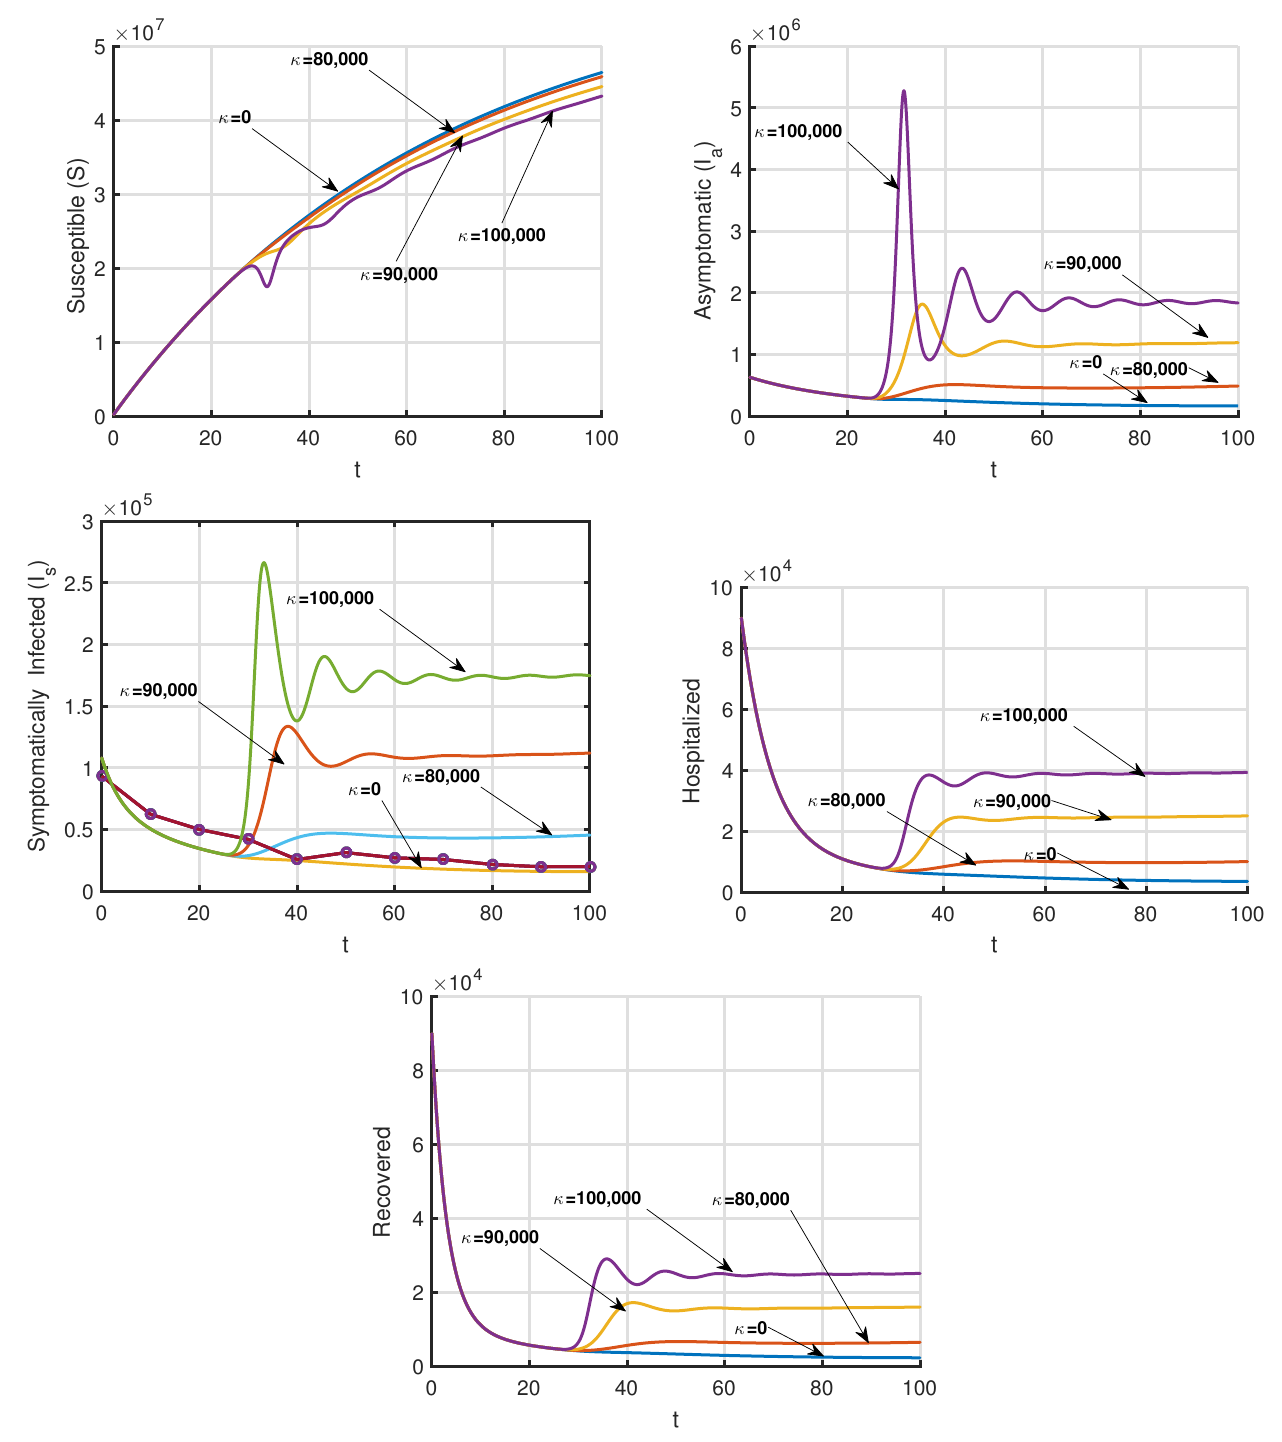
Figure 7. Variation time series with different values of κ